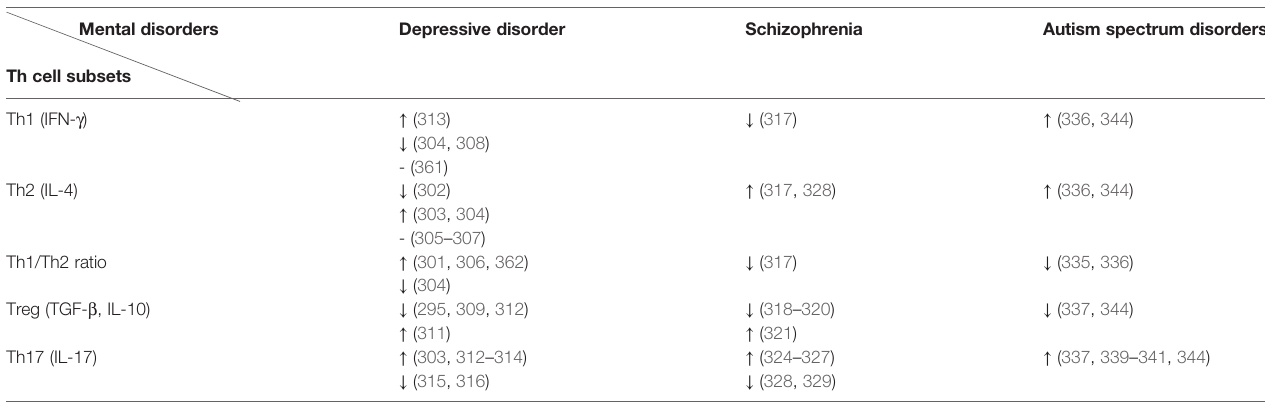
TABLE 1 | Changes of Th cell subsets or their signature cytokine levels in mental